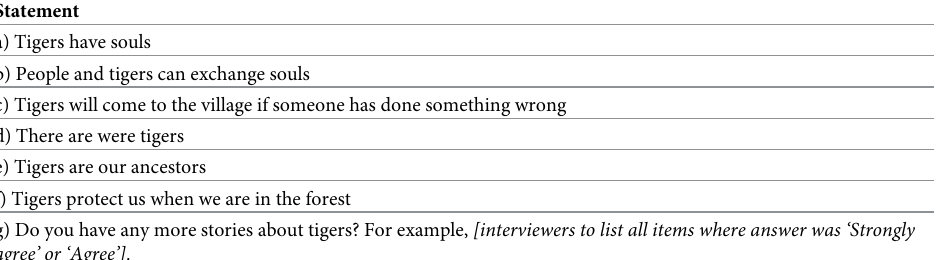
Table 1. Filter questions used to identify individuals with strong tiger-related beliefs. Answers to statements (a) to (f) were given on a five-point Likert scale ranging from strongly agree to strongly disagree. A yes/no response was recorded for (g). Respondents strongly agreeing or agreeing to any of the items (a-f), or answering yes to question (g), were invited for